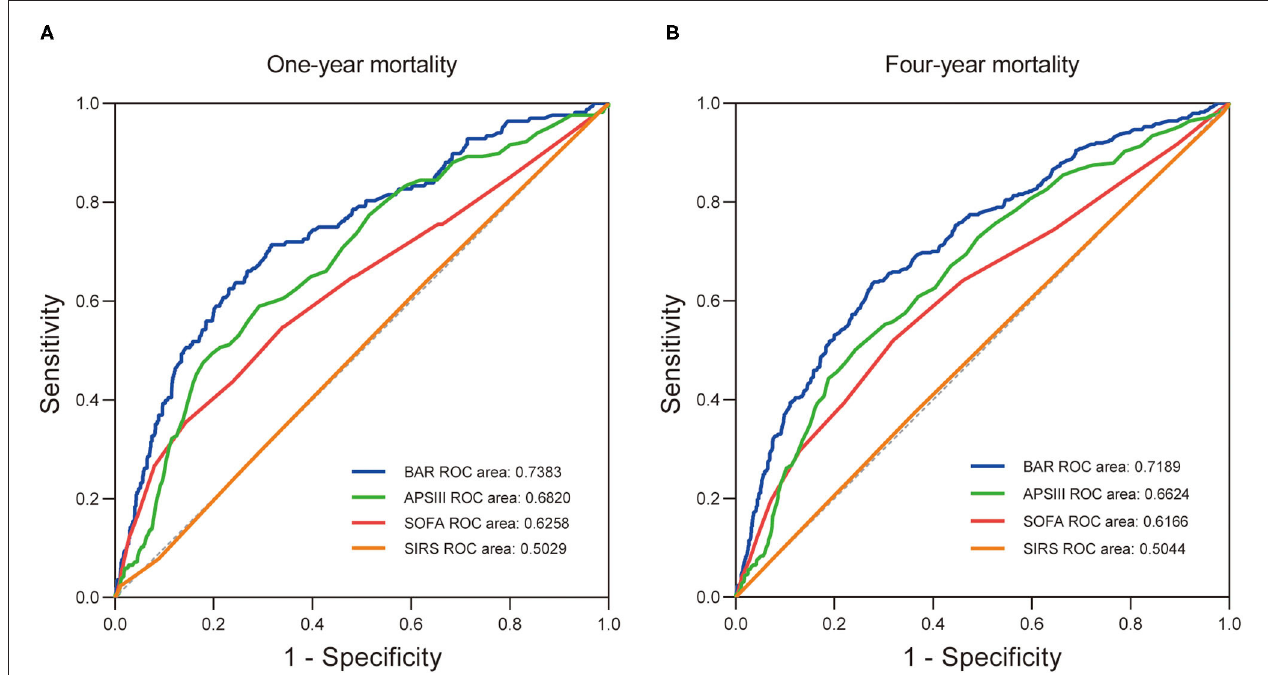
FIGURE 4 | The receiver operating characteristic curves of the predictive value of BAR, APS III, SOFA, and SIRS for 1- (A) and 4-year (B) all-cause mortality in patients after CABG. BAR, blood urea nitrogen-to-albumin ratio; APS III, acute physiology score III; SOFA, sequential organ failure assessment; SIRS, systemic inflammatory response syndrome; CABG, coronary artery bypass